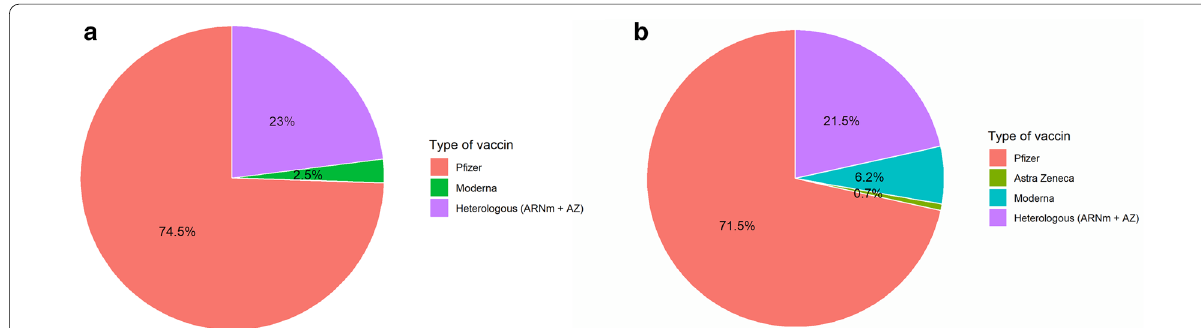
Fig. 1 Distribution of vaccine type. a Attendees (n